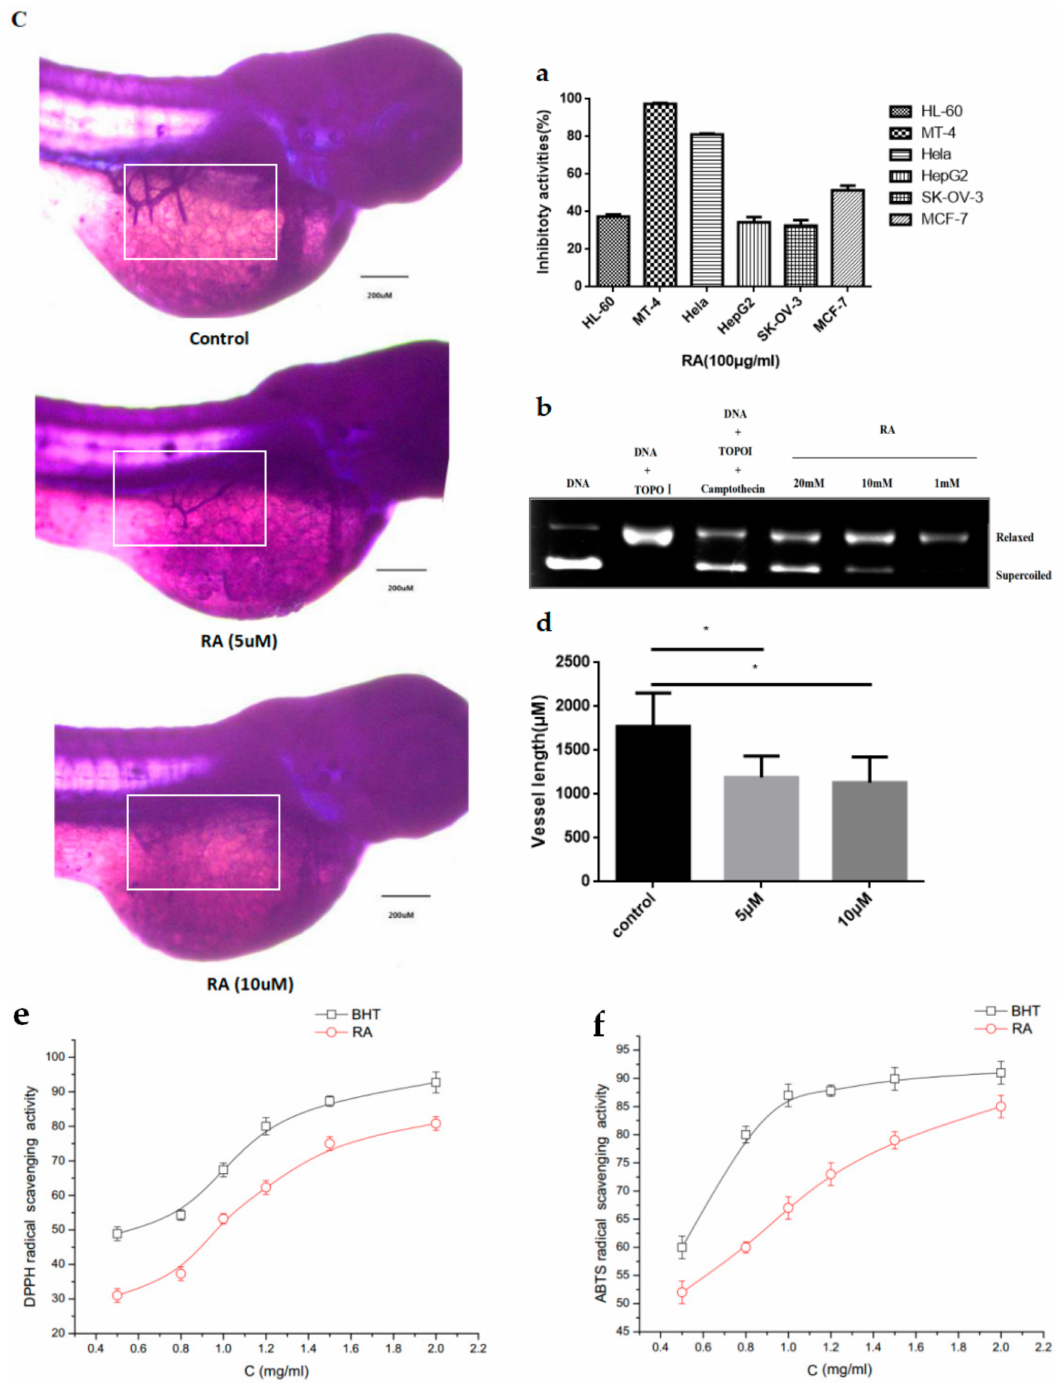
Figure 2. ( a ) The anticancer activities of RA in HL-60, MT4, Hela, HepG2, SK-OV-3and MCF-7 cell lines; ( b ) DNA Topo I inhibitory activity of RA using Camptothecin (0.1 mM) as a positive control; ( c ) Representative photographs of zebrafish SIVs. The SIVs of zebrafish embryos are indicated by a white rectangle; ( d ) E ff ects of the representative compounds and control on SIVs’ length of 72 hpf zebrafish embryos (x ± s, n = 12), * p < 0.05; ( e ) DPPH radical scavenging activity; ( f ) ABTS radical scavenging